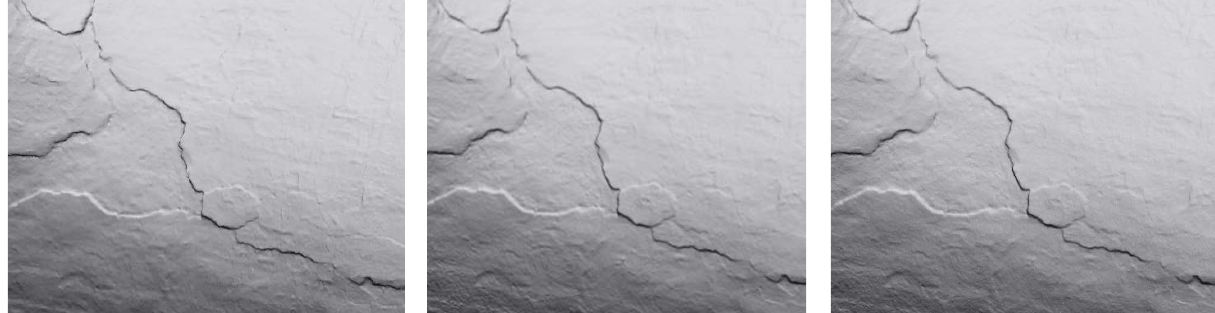
14. On the left, detail of the scanner model. In the centre, detail of the photogrammetric model from depth maps in high quality. On the right, detail of the photogrammetric model from depth maps in ultra-high